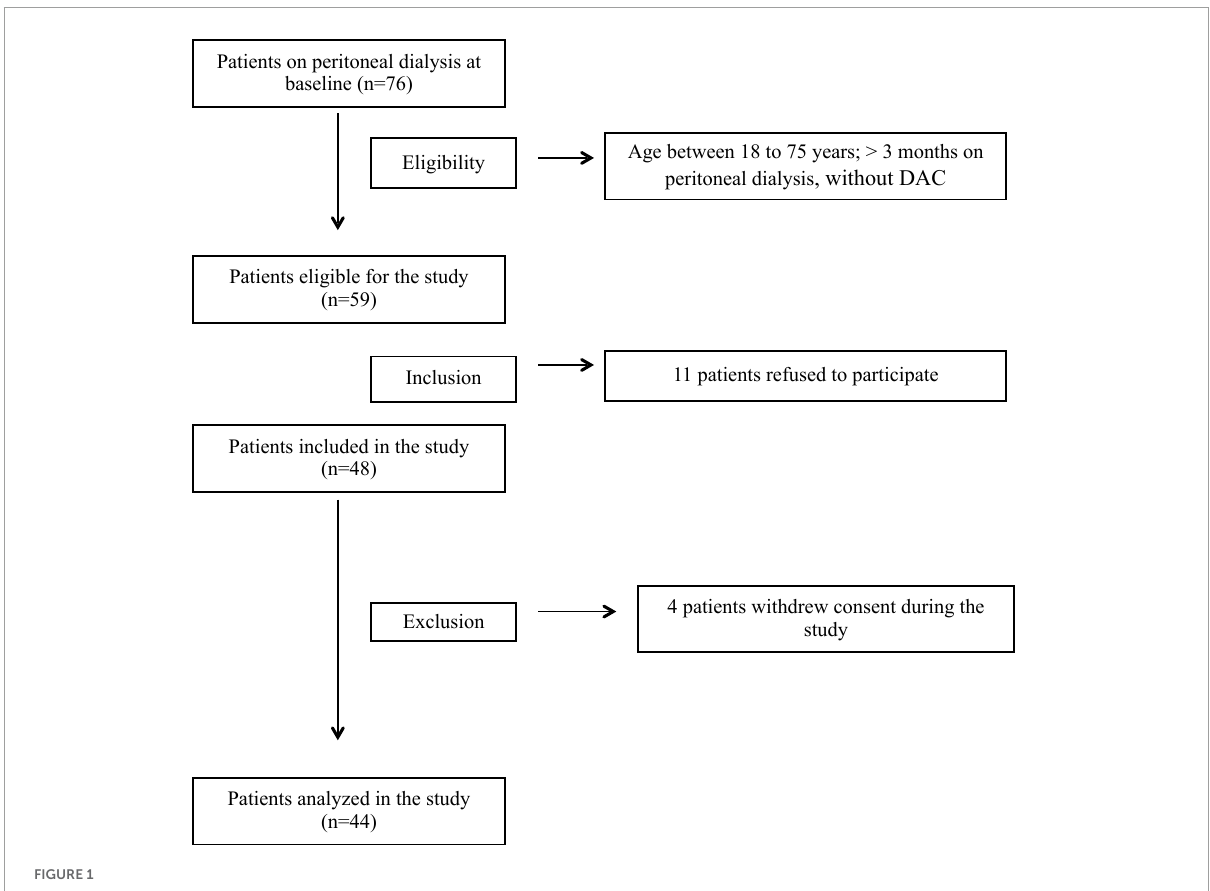
FIGURE1 Flowchart of inclusion of patients in the